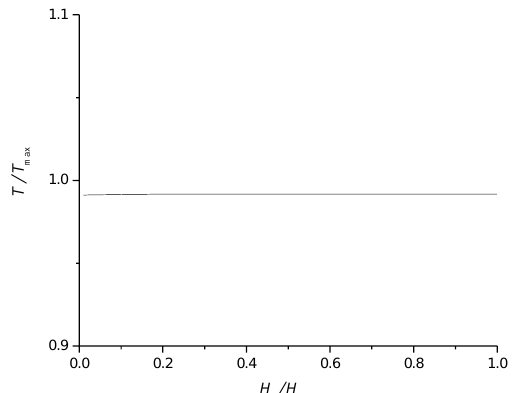
Figure 8. Temperature distribution in the height direction of the steam generator in the absence of feedwater leakage.